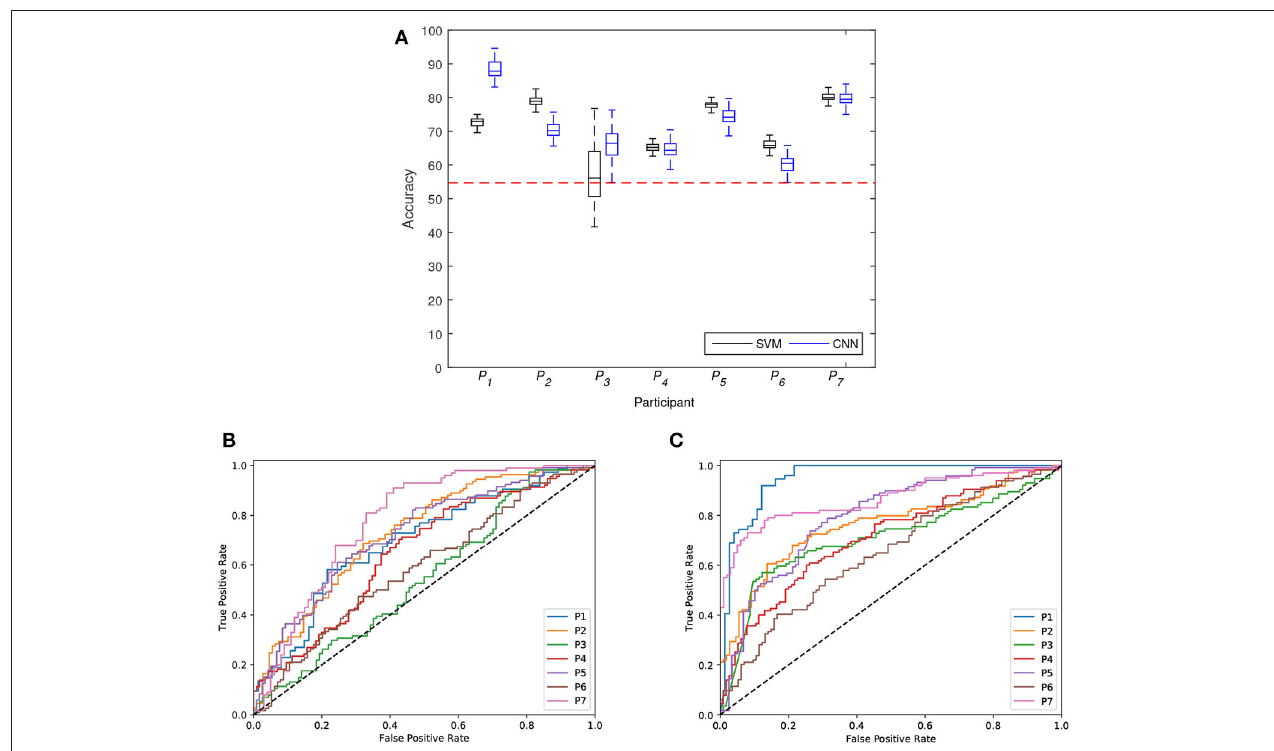
FIGURE 6 | (A) Distribution of classification accuracy achieved with SVM and CNN for each participant ( P 1 to P 7 ). The horizontal dotted red line represents the significant chance level or accuracy chance . (B) ROC curves for SVM classifiers for each participant. (C) ROC curves for CNN classifiers for each participant. The diagonal dotted black line represents the threshold AUC = 0.5.